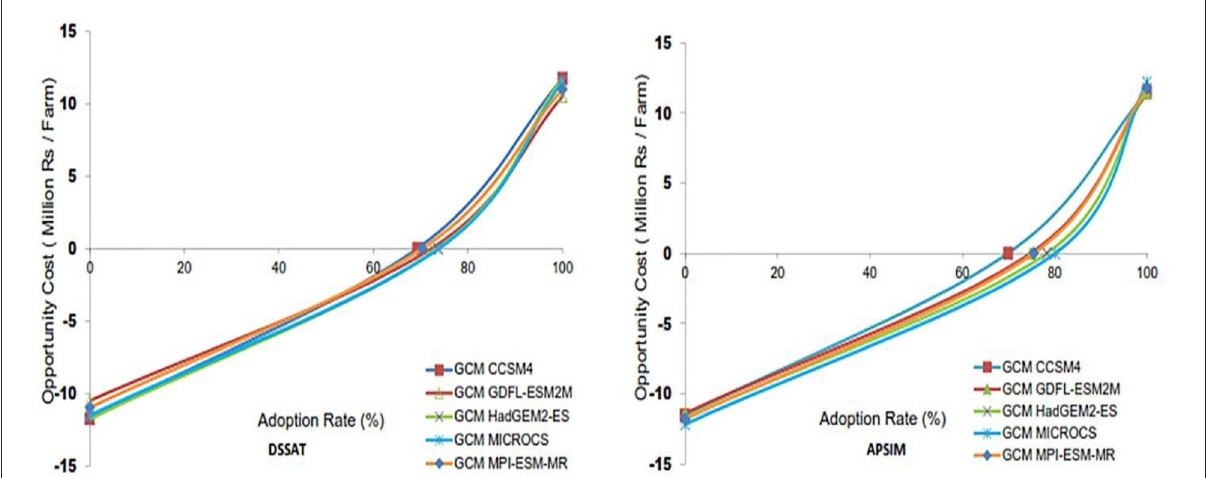
FIGURE9 Distribution of adopters and non-adopters for all 5 GCMs (with adaptation and with trend). The percentage of adopters due to adaptation technologies for DSSAT and APSIM in rice-wheat cropping system would be between 92 and 93% and 93 and 94%, respectively. For DSSAT and APSIM estimated per head income with adaptation cases will be from Rs. 89 to 100 and 93 to 97 thousand and from Rs. 156 to 174 and 166 to 181 thousand per head respectively in a